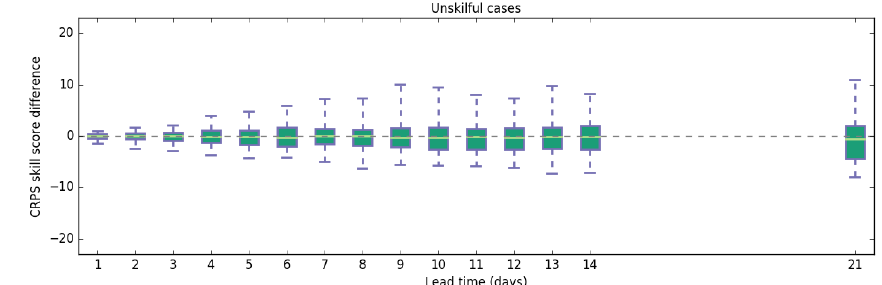
ARW, with the median marked by the line crossing the